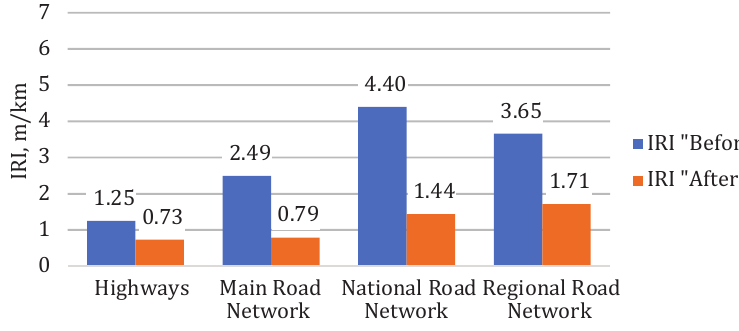
Figure 3. Change in IRI after renewal of the asphalt wearing